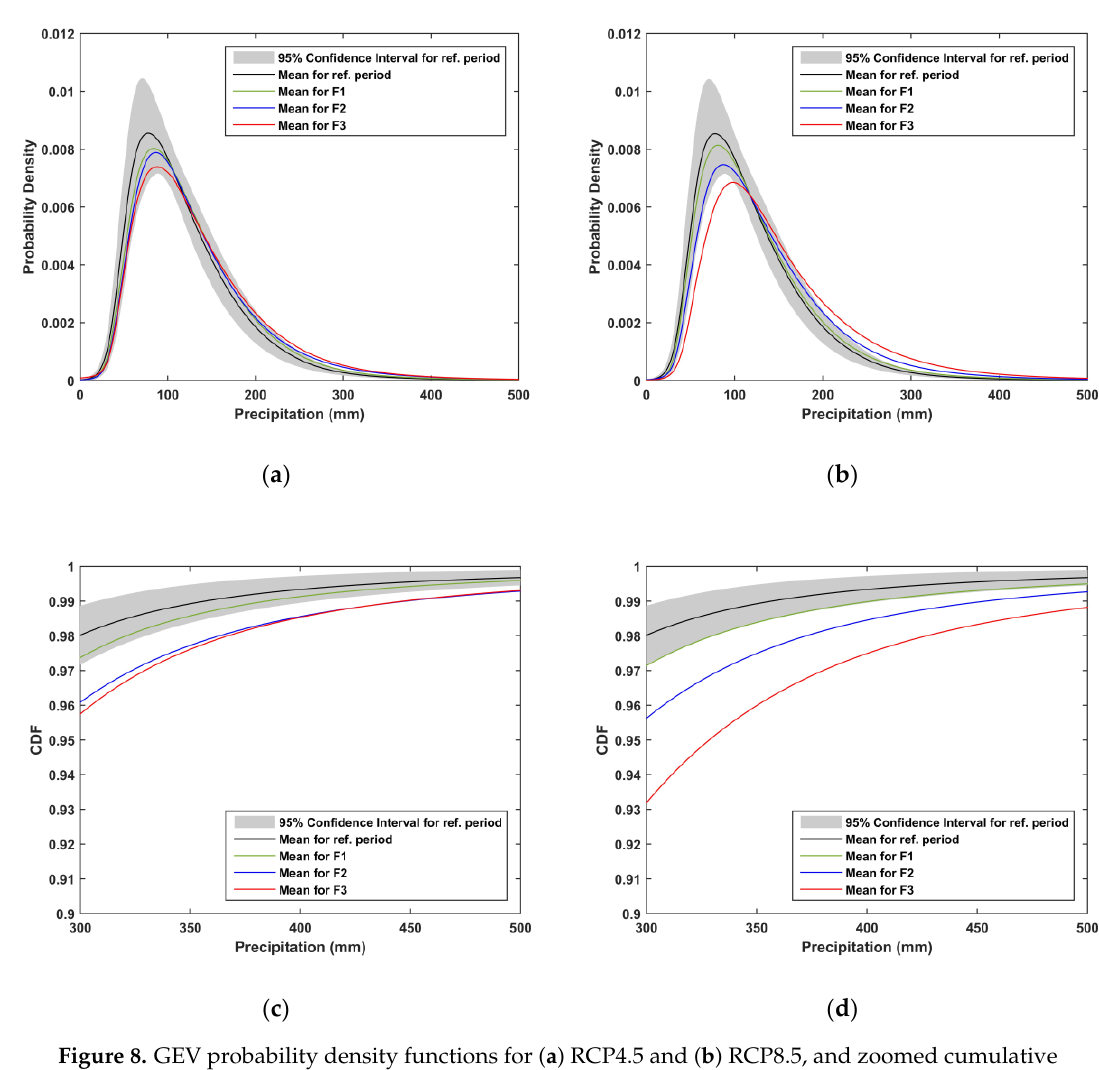
Figure 8. GEV probability density functions for ( a ) RCP4.5 and ( b ) RCP8.5, and zoomed cumulative distribution functions (CDFs) for extremes for ( c ) RCP4.5 and ( d ) RCP8.5.